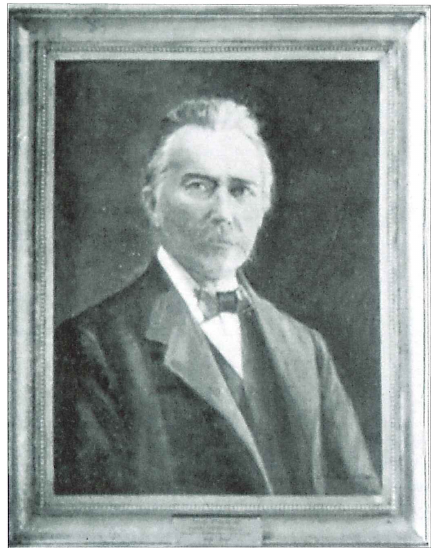
Fig. 4a. Jonas Westman was born 1867 in Nora, a rural parish lo- cated on the Baltic coast of Sweden between Sundsvall and